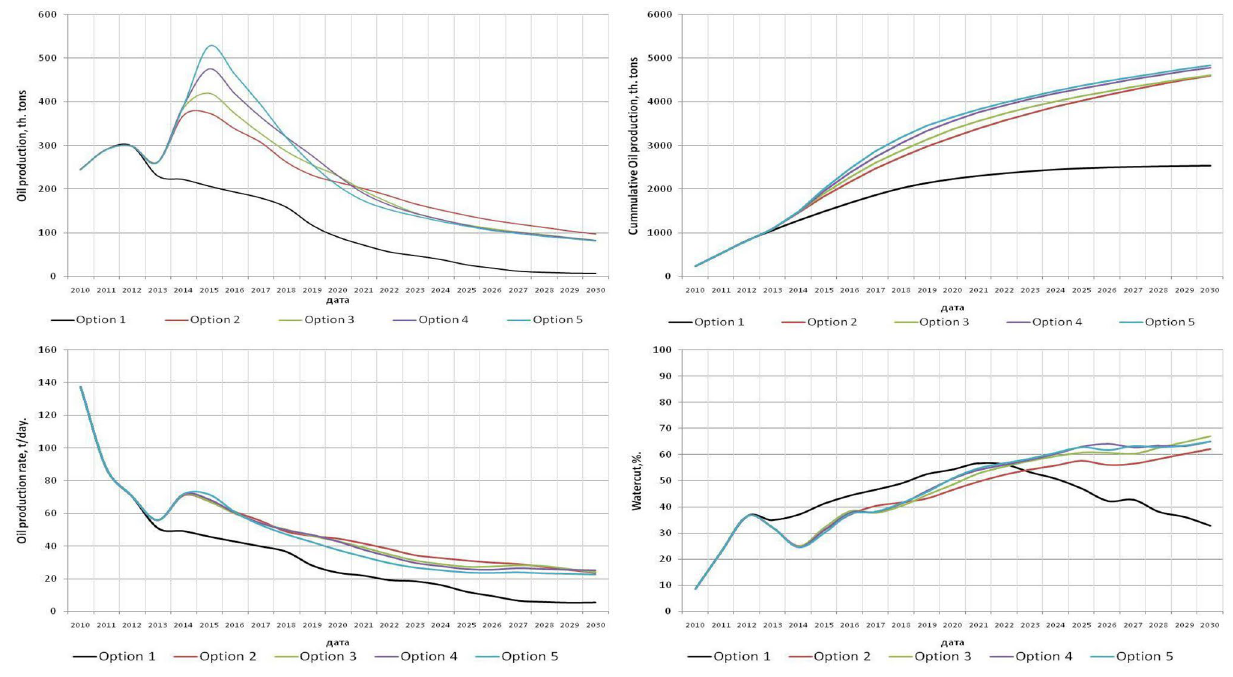
Fig. 13 Predictive technological parameters of development options